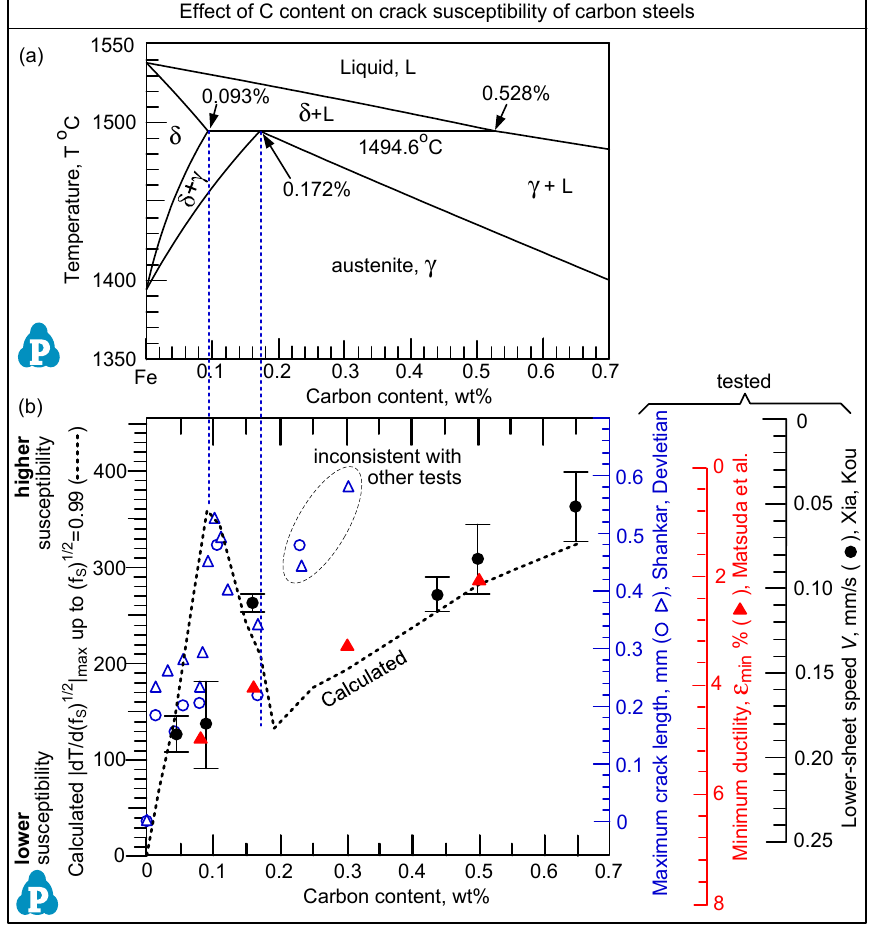
Figure 9. The effect of carbon content on the susceptibility of carbon steels to solidification cracking in arc welding: (a) binary Fe-C phase diagram; (b) comparison between calculated susceptibility and experimental data. Xia and Kou data from [21].